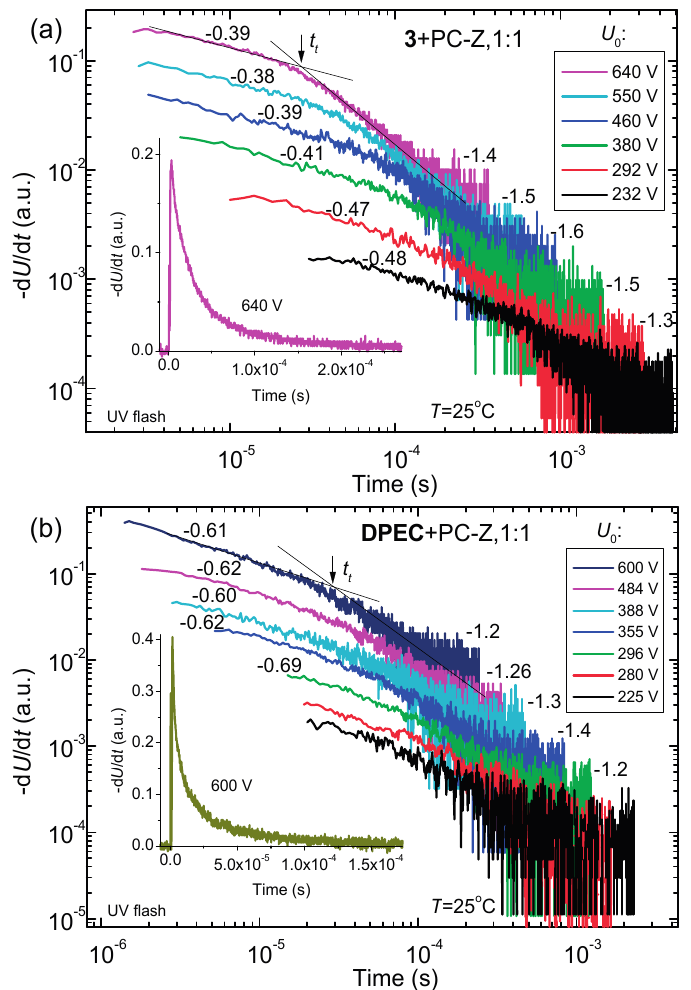
Figure 7. XTOF transients for the 3 ( a ) and DPEC ( b ). Insets show one transient curve in linear